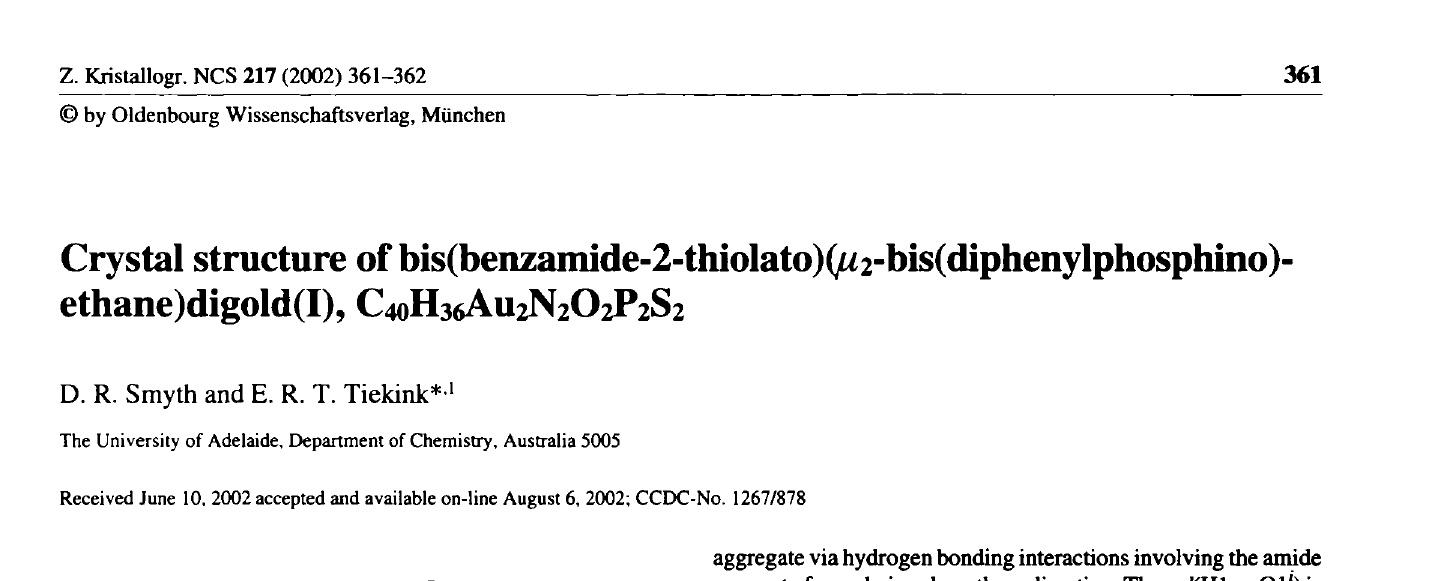
Table 1. Data collection and handling.